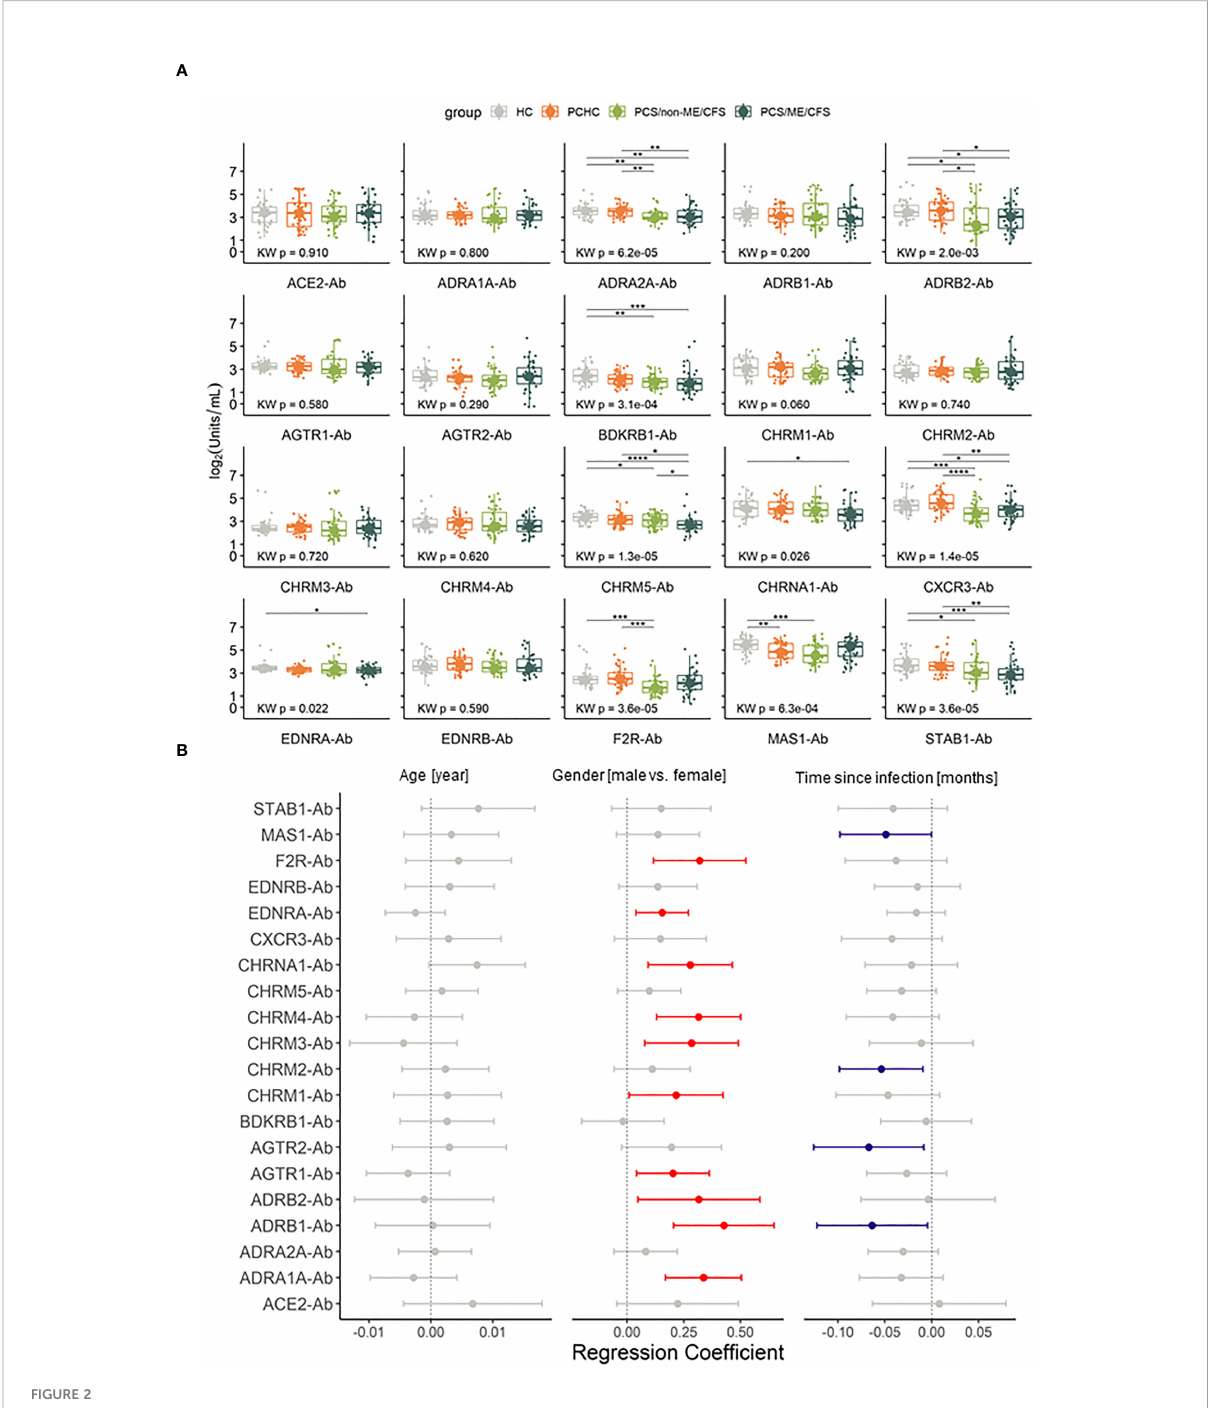
FIGURE 2 Autoantibodies (-Ab) against G protein coupled receptors (GPCR) and COVID-19-associated molecules are dysregulated during Post COVID Syndrome (PCS). (A) Box plots of Ab investigated in PCS patients with and without ME/CFS and healthy controls post or without COVID-19 history (PCHC or HC). Signi fi cance determined by Kruskal Wallis test followed by Dunn test as post hoc . Dunn test p values were corrected for FDR. Adjusted p-values are being represented by: *p.adj < 0.05; **p.adj <0.01; ***p.adj < 0.001; ****p.adj < 0.0001. Boxes represent the median and interquartile range (IQR). (B) Forest plot of regression coef fi cients for the confounding factors age in years, gender (reference being female) and time post COVID-19 in months considering 95% con fi dence interval (CI). Red dots and CI indicate that variable has a positive in fl uence in the Ab level, blue dots and CI indicate a negative in fl uence and gray ones contain 0 in the con fi dence interval, therefore are taken as non signi fi